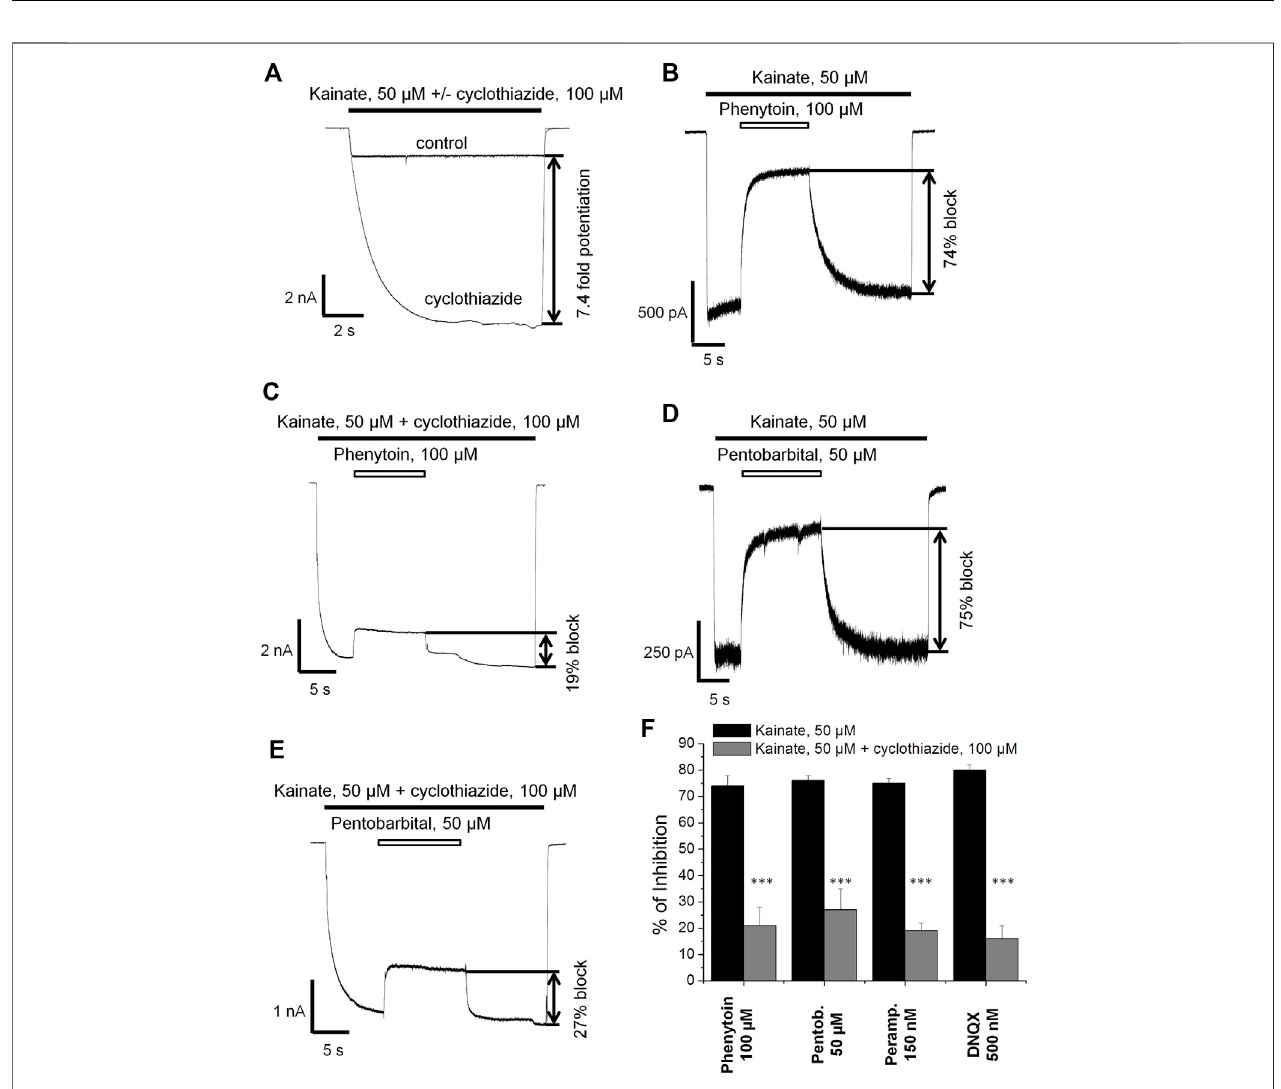
FIGURE 5 | The effect of phenytoin is attenuated in the presence of cyclothiazide. (A) Enhancement of kainate-induced currents in hippocampal CA1 pyramidal neurons by 100 µMcyclothiazide. (B,C) Representativeexamplesofinhibitionby100 µMphenytoinintheabsence (B) andpresence (C) of100 µMcyclothiazide. (D,E) Representativeexamplesof inhibitionby50 µMpentobarbitalintheabsence (D) andpresence (E) of100 µMcyclothiazide. (F) SummarizedresultsofCI-AMPARsinhibitionbydifferentcompoundsintheabsence and presence of 100 µM cyclothiazide. The inhibitory effect of compounds was signi fi cantly attenuated in the presence of cyclothiazide. *** – p < 0.001.